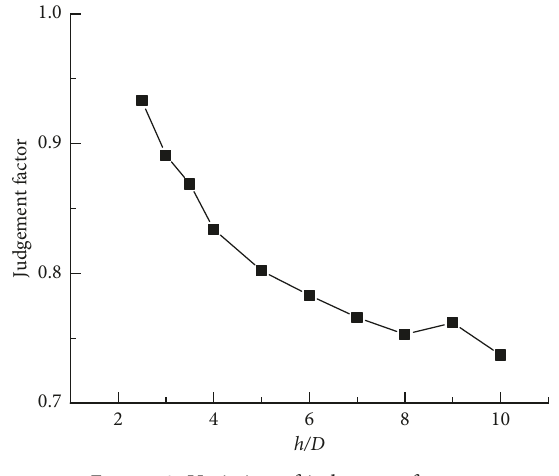
Figure 8: Variation of judgement Table 3: Basic properties of the soil.